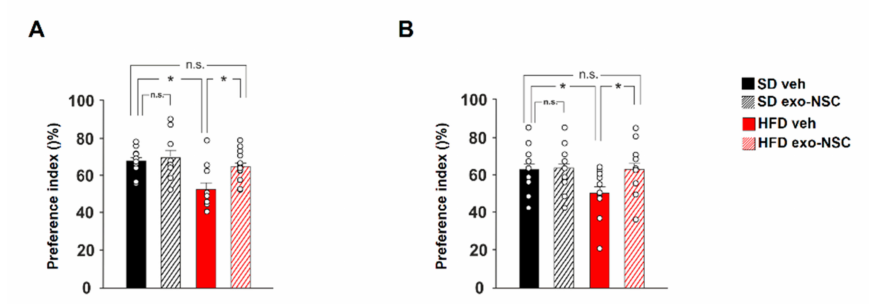
Figure 5. NSC-derived exosomes counteract HFD-related memory deficits. ( A ) Preference index for the novel object in the novel object recognition (NOR) paradigm in SD and HFD mice treated with vehicle or exo-NSC ( n = 10 for SD vehicle, 9 SD exo-NSC, 10 for HFD vehicle, 15 HFD exo-NSC; statistics using two-way ANOVA and Bonferroni post hoc). ( B ) Preference index for the displaced object in the object place recognition (OPR) paradigm in SD and HFD mice treated with vehicle or exo-NSC ( n = 10 for each group; statistics using two-way ANOVA and Bonferroni post hoc). Data are expressed as mean ± SEM. * p < 0.05; n.s., not